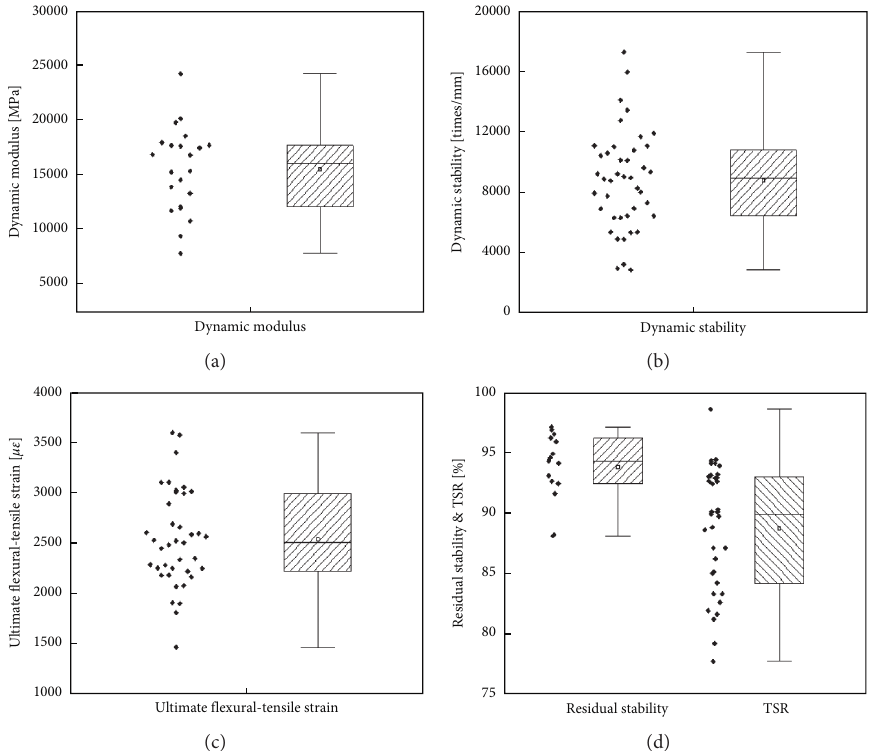
Figure 9: Performance of admixture high modulus asphalt mixture [28, 30, 32, 36, 39, 42–54]: (a) dynamic modulus; (b) dynamic stability; (c) ultimate flexural-tensile strain; (d) residual stability and